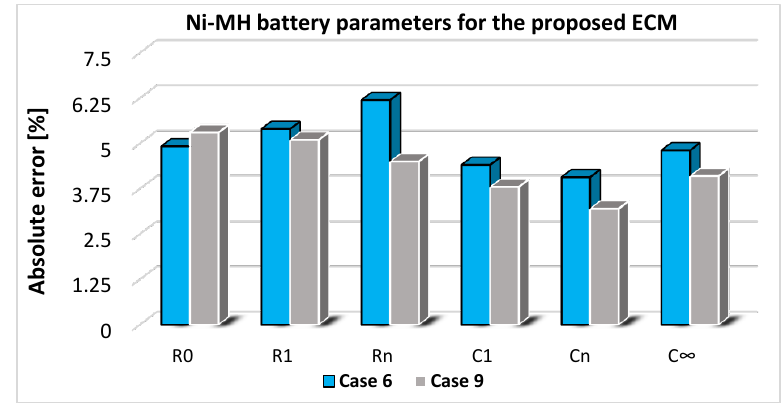
Figure 18. Error plot of Ni-MH battery for each of the parameters. Table 19. Results of Case 6 for Ni-MH.